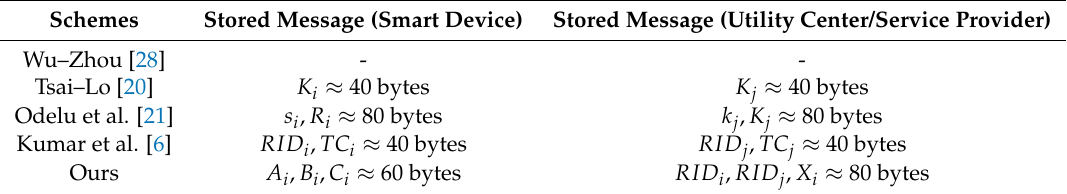
Table 8. A comparative summary: storage